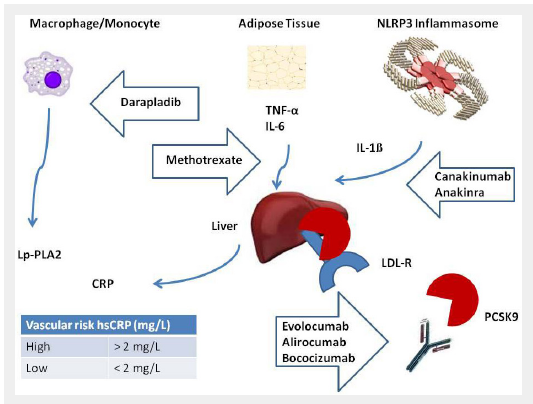
Targeting inflammatory and lipid pathways for the treatment of cardiovascular disease. Monoclonal antibodies against PCSK9 (evolocumab, alirocumab and bococizumab) decrease circulating LDL-C by an increase of LDL-R at the hepatocyte surface. Monoclonal antibodies against IL-1β (canakinumab) are currently being tested in the CANTOS trial [37]. Anakinra, an inhibitor of IL-1β, has been tested in the VCU-ART studies [46]. Methotrexate, an inhibitor of TNFα, IL-6 and hsCRP, is currently being tested in the CIRT trial [38]. Darapladib has been tested in the SOLID-TIMI 52 and STABILITY trials [44, 45]. CANTOS = Canakinumab Anti-inflammatory Thrombosis Outcomes Study; CIRT = Cardiovascular Inflammation Reduction Trial; hsCRP = high-sensitive C-reactive protein; IL = interleukin; LDL-C = low- density lipoprotein cholesterol; LDL-R = low-density lipoprotein receptor; PCSK9 = proprotein convertase subtilisin / kexin type 9; SOLID-TIMI 52 = stabilization of plaque using darapladib- thrombolysis in myocardial infarction 52; STABILITY = stabilization of atherosclerosis plaque by initiation of darapladib therapy. TNF = tumour necrosis factor; VCU-ART = Virginia Commonwealth University anakinra remodeling trial. Figure adapted from Ridker